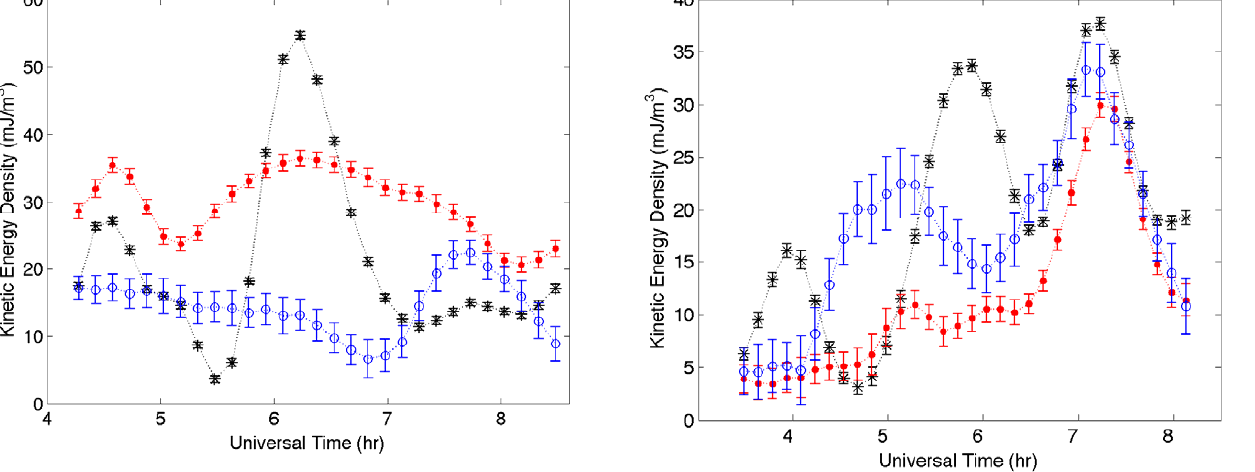
Figure 5. Kinetic energy density on June 19, 2002 in the same format as Figure 1. Potential Fig. 5. Kinetic energy density on 19 June 2002 in the same for- mat as Fig. 1. Potential energy per unit mass (J/kg) can be found energy per unit mass (J/kg) can be found by multiplying the KED by: 2.3 (Low), 0.46 (Middle) by multiplying the KED by: 2.3 (Low), 0.46 (Middle) and 0.052 and 0.052 (High).